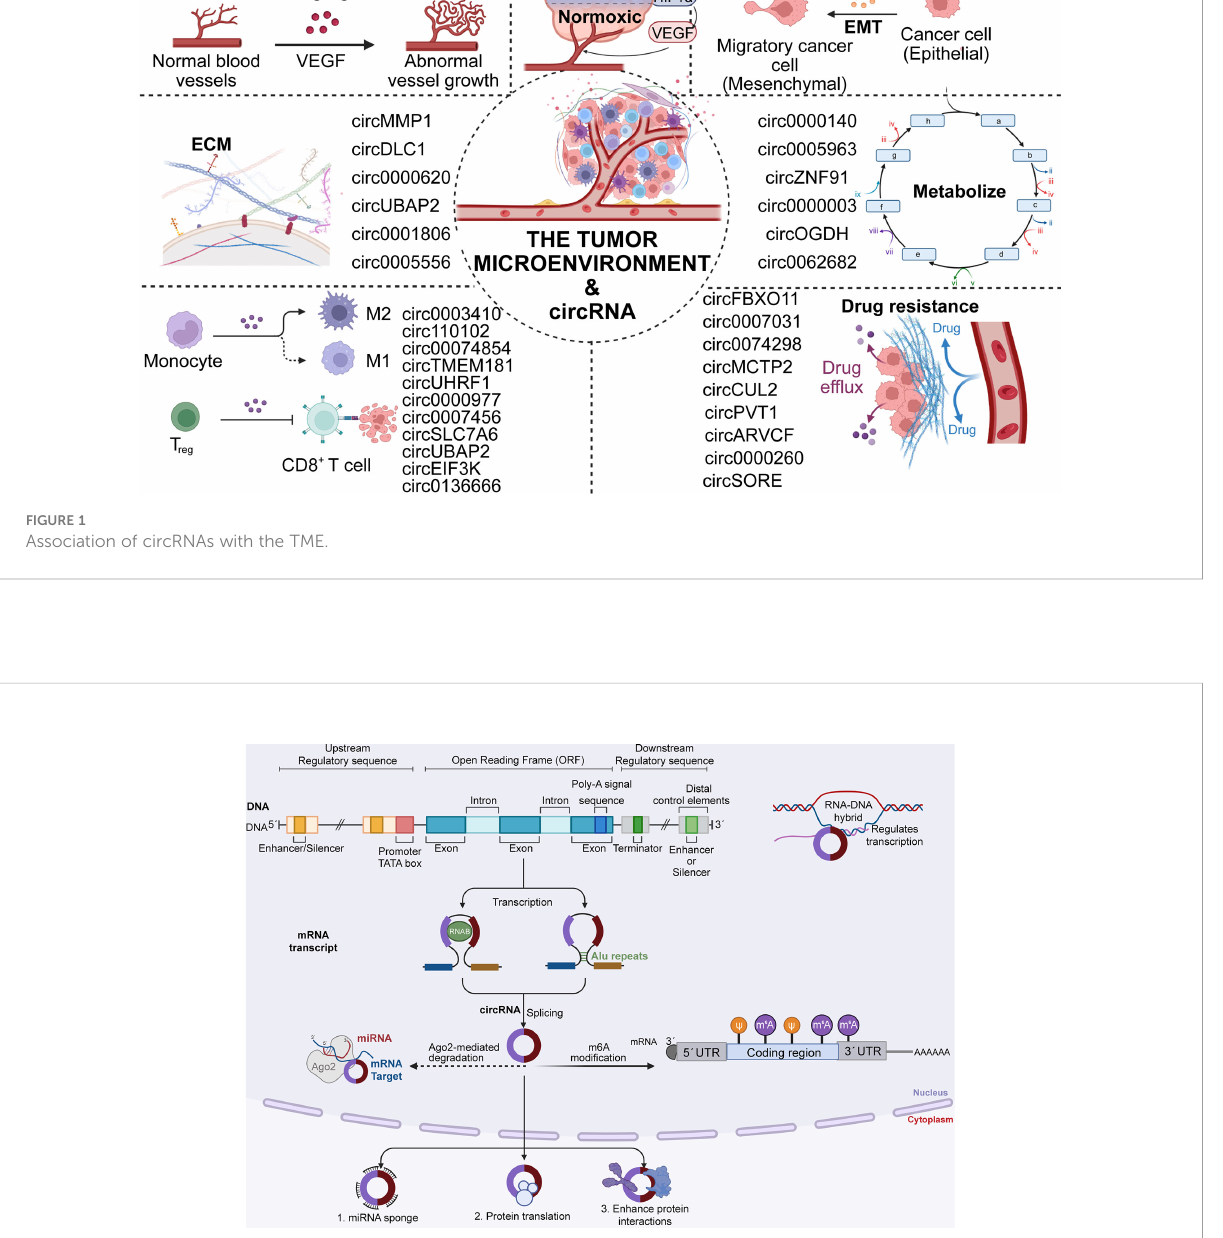
FIGURE 2 DNA generates circRNA precursors by transcribing local exons, and mature circRNAs are formed by reverse splicing. CircRNA degrades in two ways: 1) RNA degradation mediated by AGO2 protein, in which MiRNA binds to circRNA fi rst and then guides AGO2 to perform dependent cleavage; and 2) m6A modi fi cation, and CircRNA can be cleaved by endoribonuclease after m6A modi fi cation. Mature circRNA functions in three ways: as a miRNA sponge to regulate downstream targets, translate proteins, and enhance protein reactions.